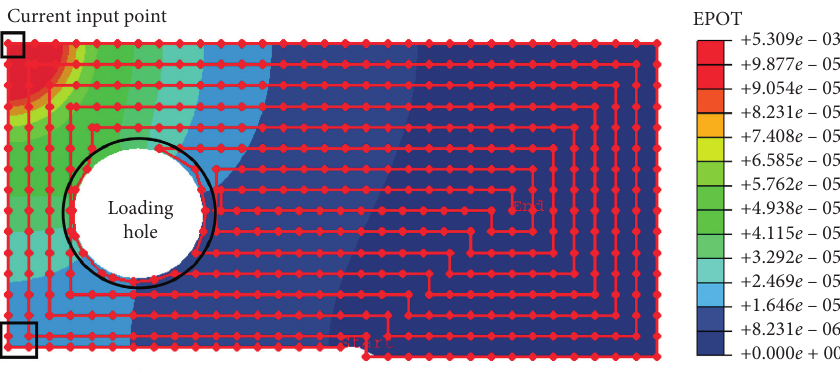
Figure 5: The distribution of reference potential probe points of the CT